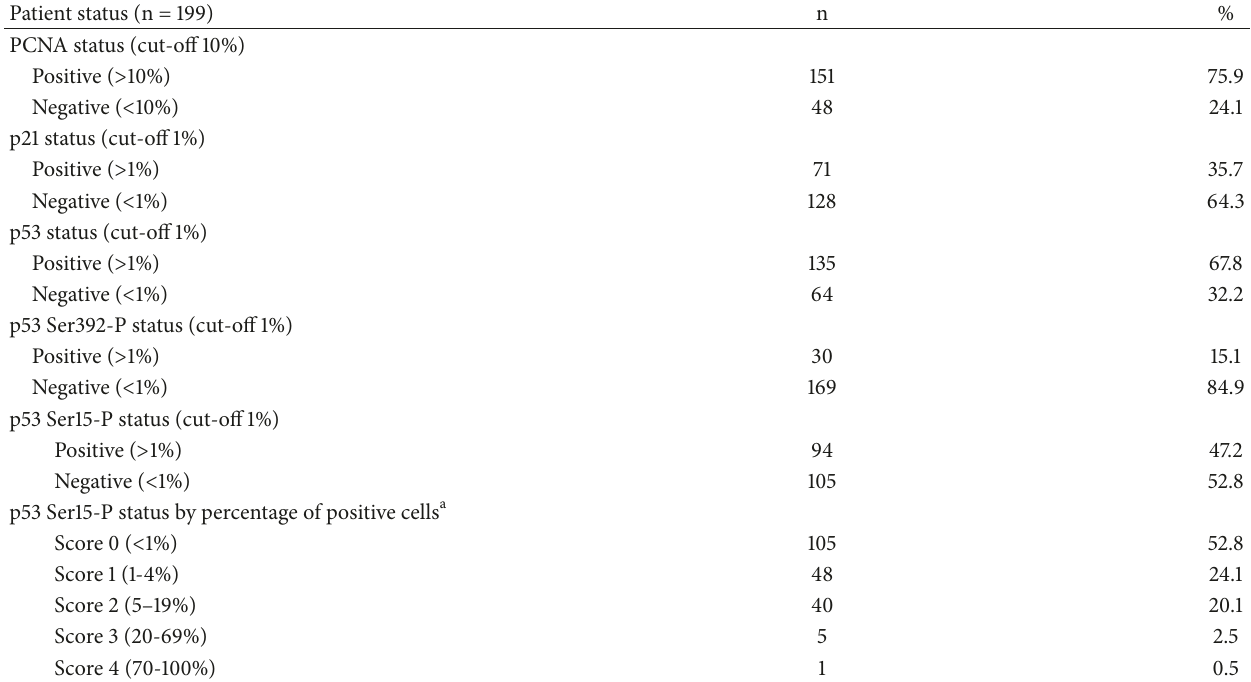
Table 2: Frequency of PCNA, p21, p53, p53 Ser15-P, and p53 Ser392-P expression and scoring of p53